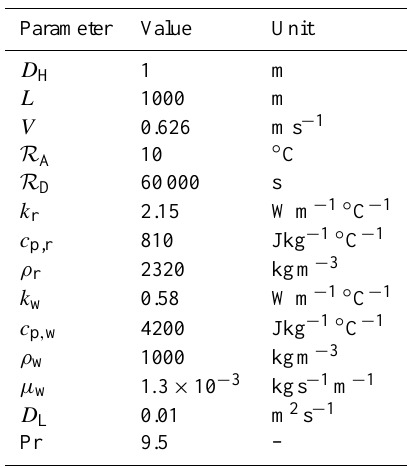
Table 1. Default parameters used in